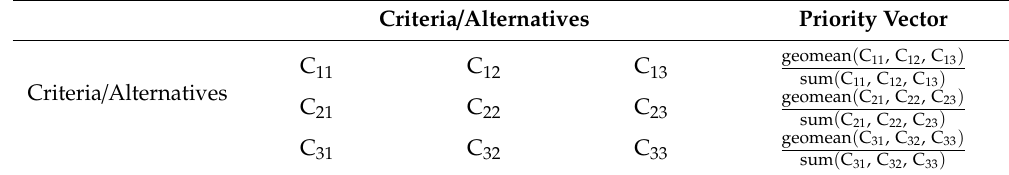
Table 4. The pairwise comparisons considering three criteria / alternatives.